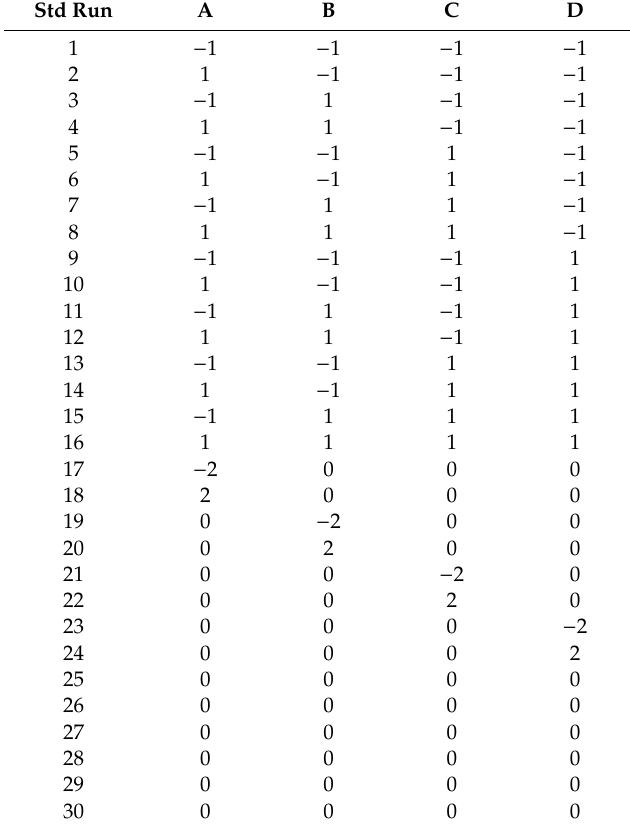
Table 14. CCD matrix for four variables with coded values for tryptophan production by P. acidilactici